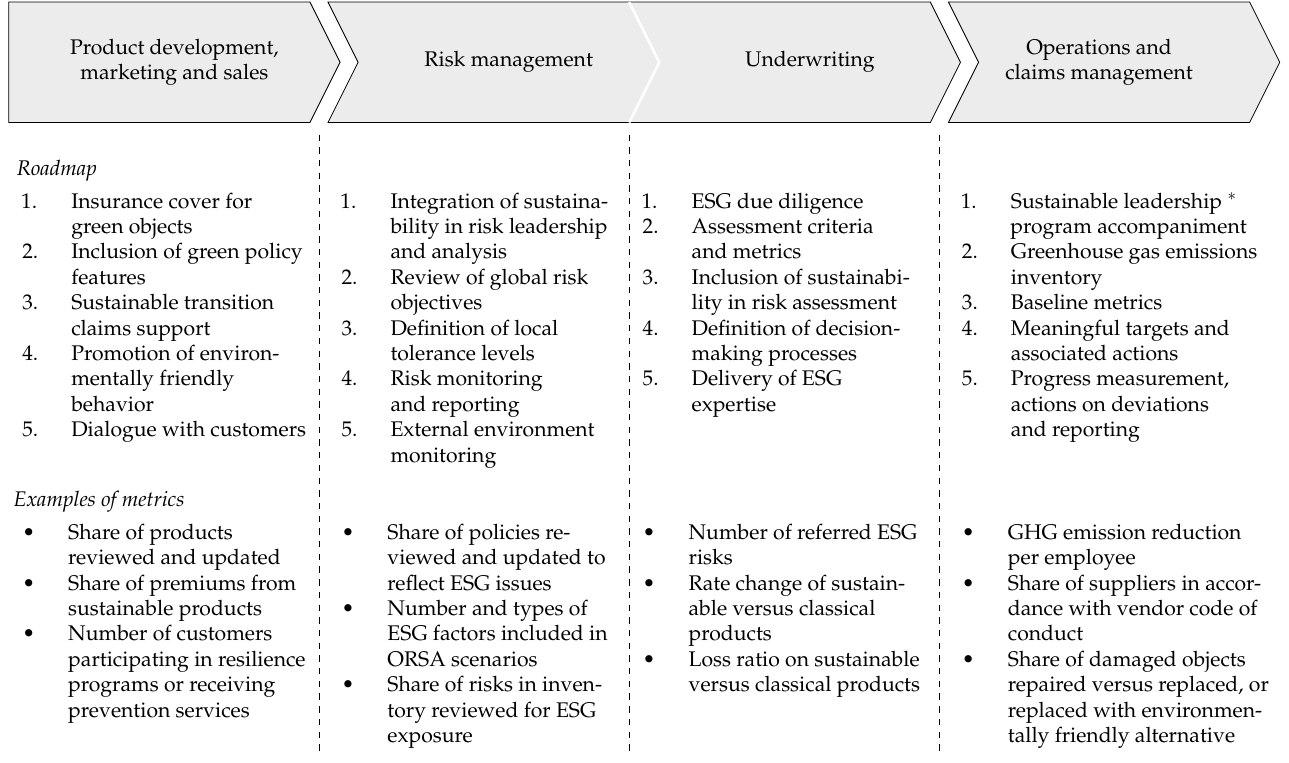
Figure 3. Roadmap and metrics along the core elements of an insurance company’s value chain. Overarching themes across all steps of the value chain and encompassing key partners are (1) to analyze the current position and exposure in regards to sustainability issues, (2) to update strategic and functional goals and responsibilities to set the tone from the top, (3)